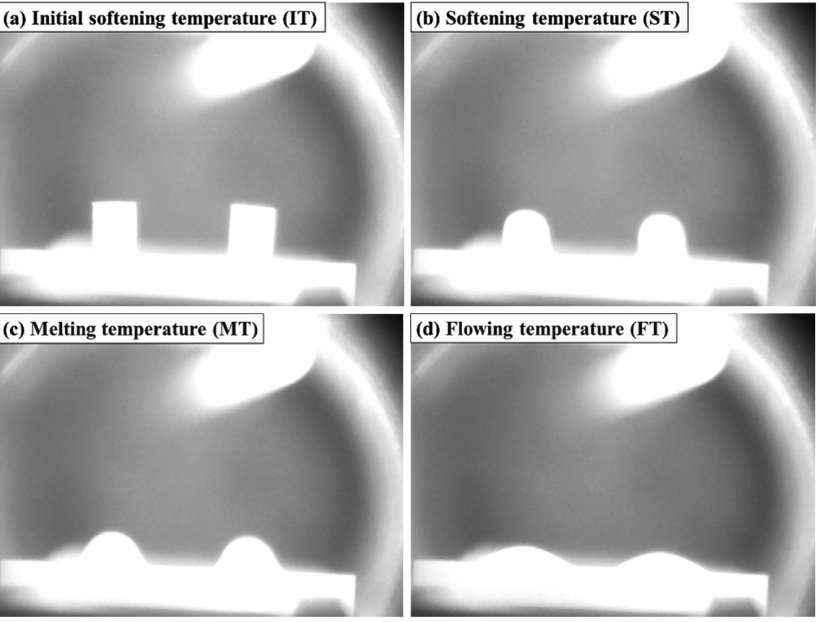
Figure 2: Melting features of the slag.